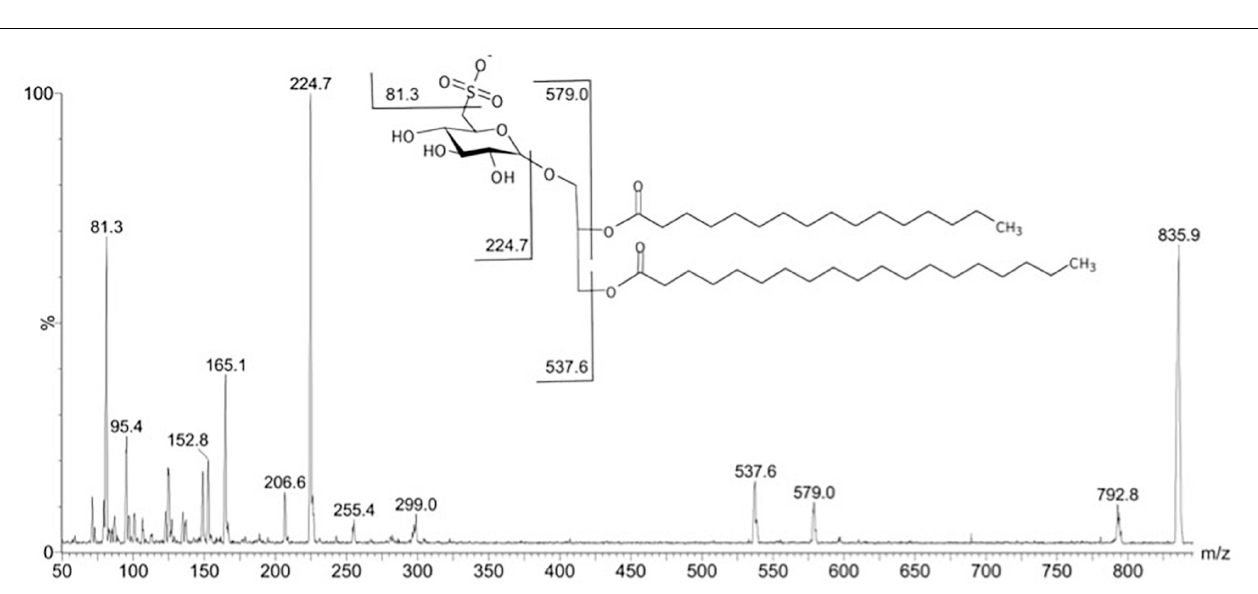
Frontiers in Marine Science |